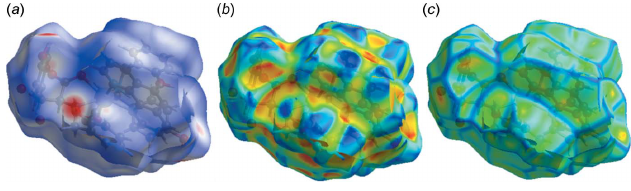
Figure 5 Hirshfeld surfaces mapped over ( a ) d norm , ( b ) shape index and ( c )